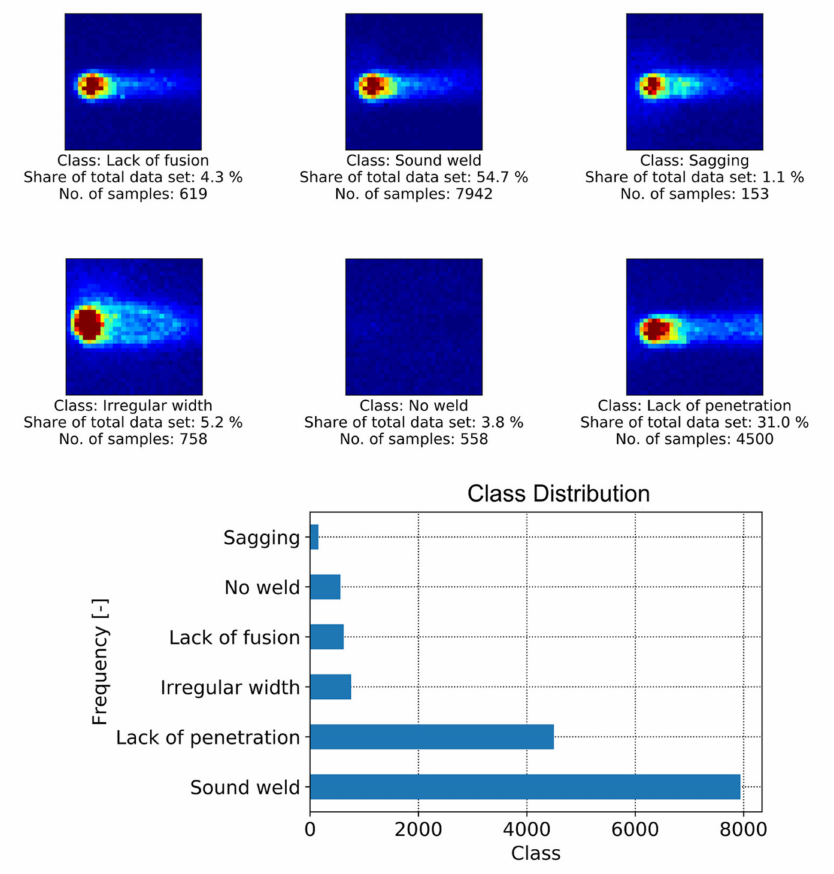
Figure 5. Example of MWIR image data and sample distribution of different quality states based on 13 weld trials (14,530 samples) that form the welding data